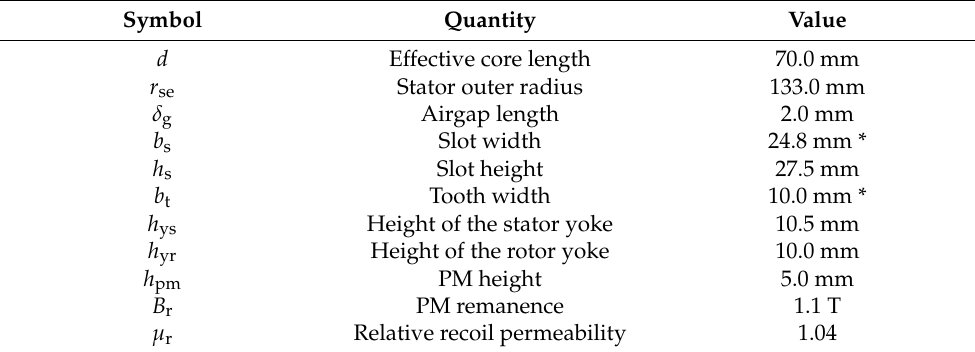
Table 1. Main data of the machines (MPMSM and PMSM).